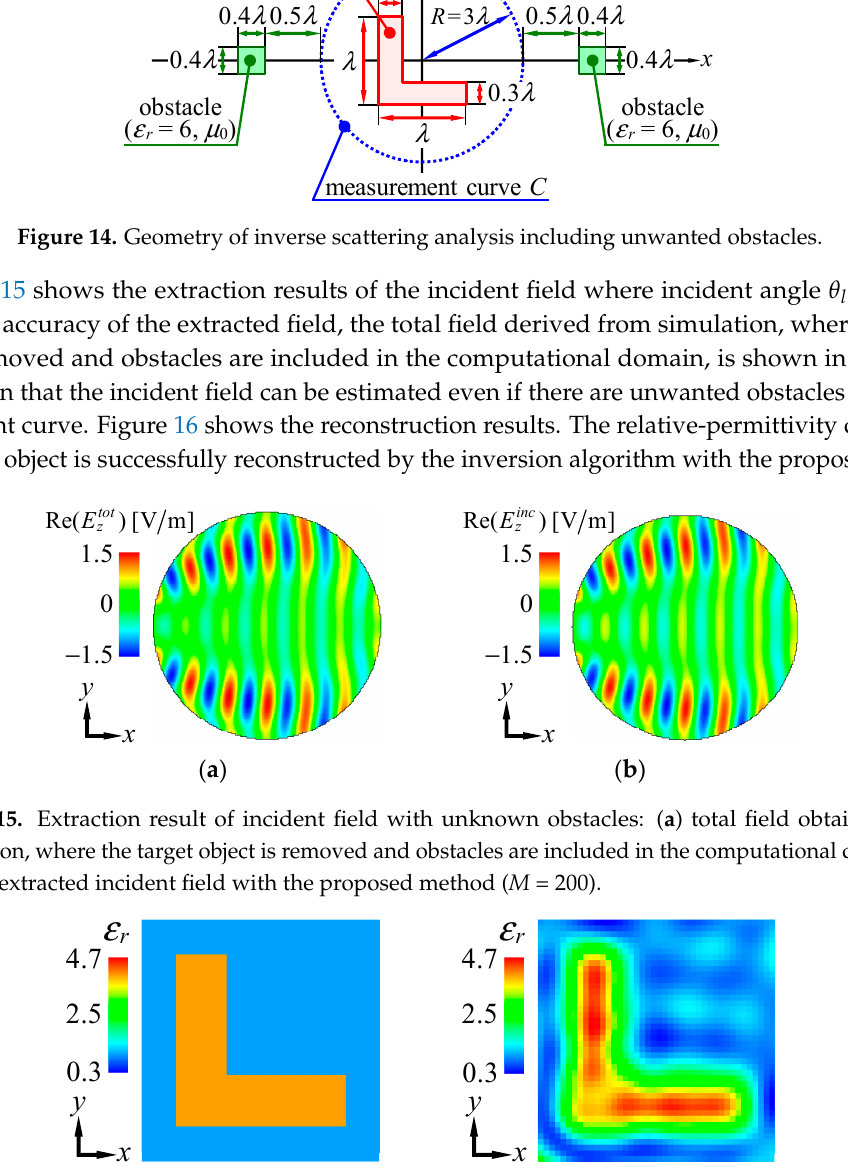
Figure 16. Reconstruction results of a situation where two unwanted obstacles exist in the exterior region Ω e : ( a ) true image and ( b ) reconstructed image using information on the extracted incident field.